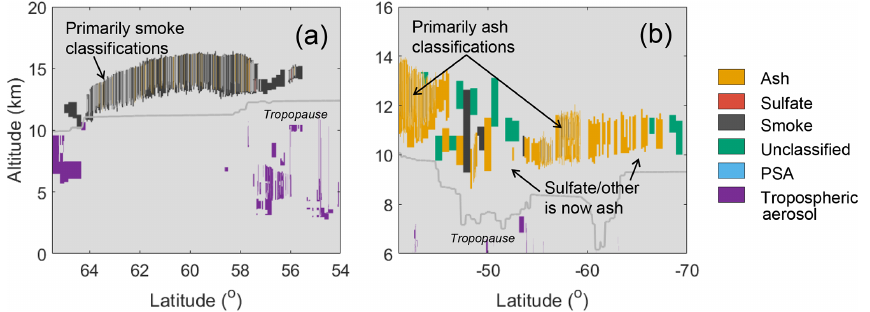
Figure 11. Aerosol subtyping after V4.5 revisions for (a) pyroCb smoke plume from the PNW event (compare with Fig. 1) and (b) volcanic ash plume from the June 2011 Puyehue-Cordón Caulle eruption (compare with Fig. 2).